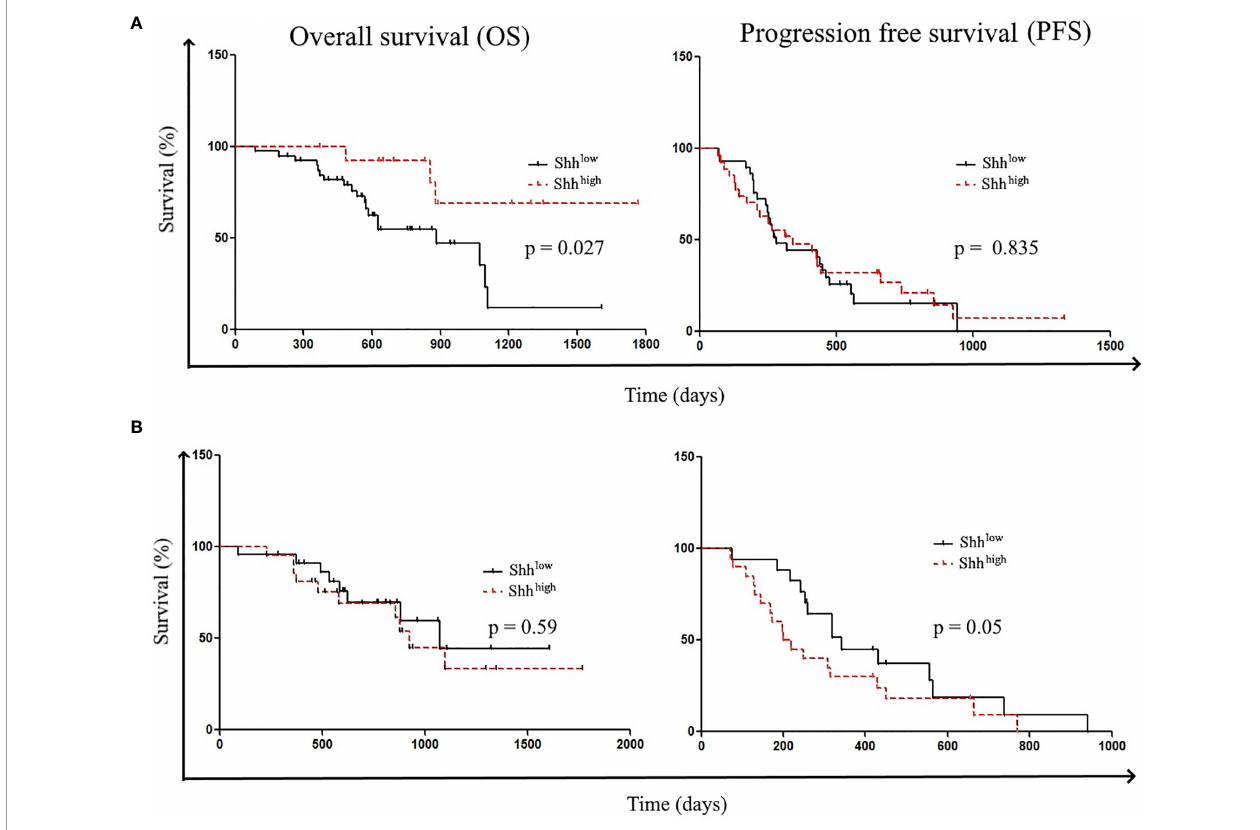
FIGURE 4 | Patient ’ s survival according to Shh levels: Patient survivals were classi fi ed according to (A) Shh levels at diagnosis (Shh low vs. Shh High ) and (B) Shh levels at the fi rst evaluation (Shh low vs. Shh High